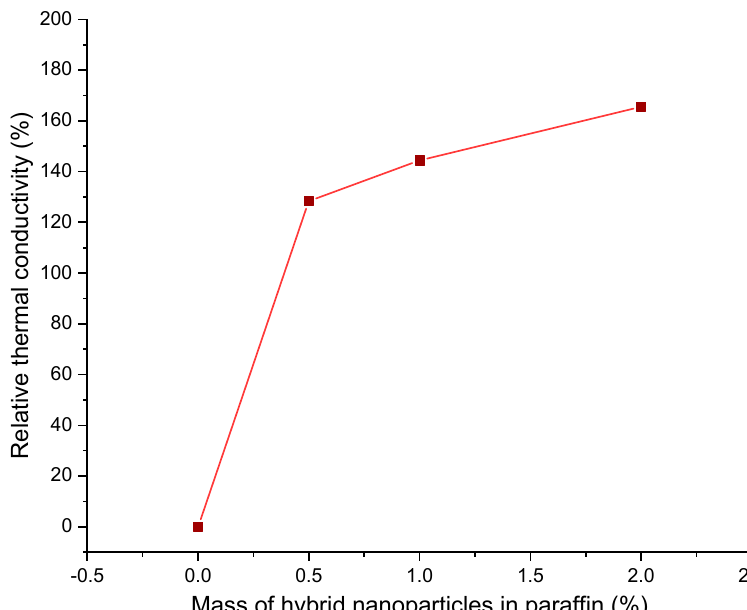
Figure 10. Relative thermal conductivity of hybrid-nano / para ffi n